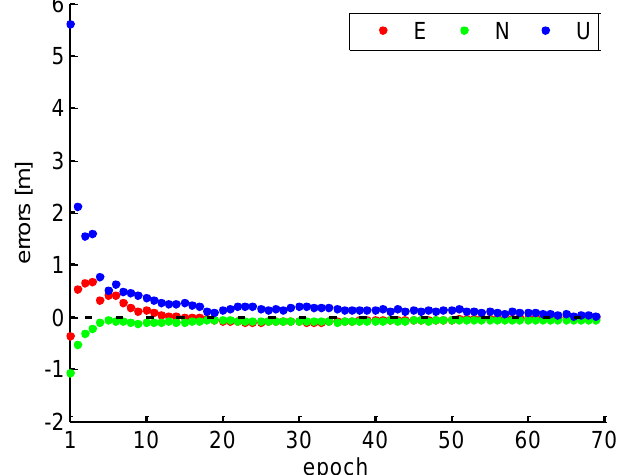
Figure 11. PPP solutions with cycle slip fixing in 180 s intervals.